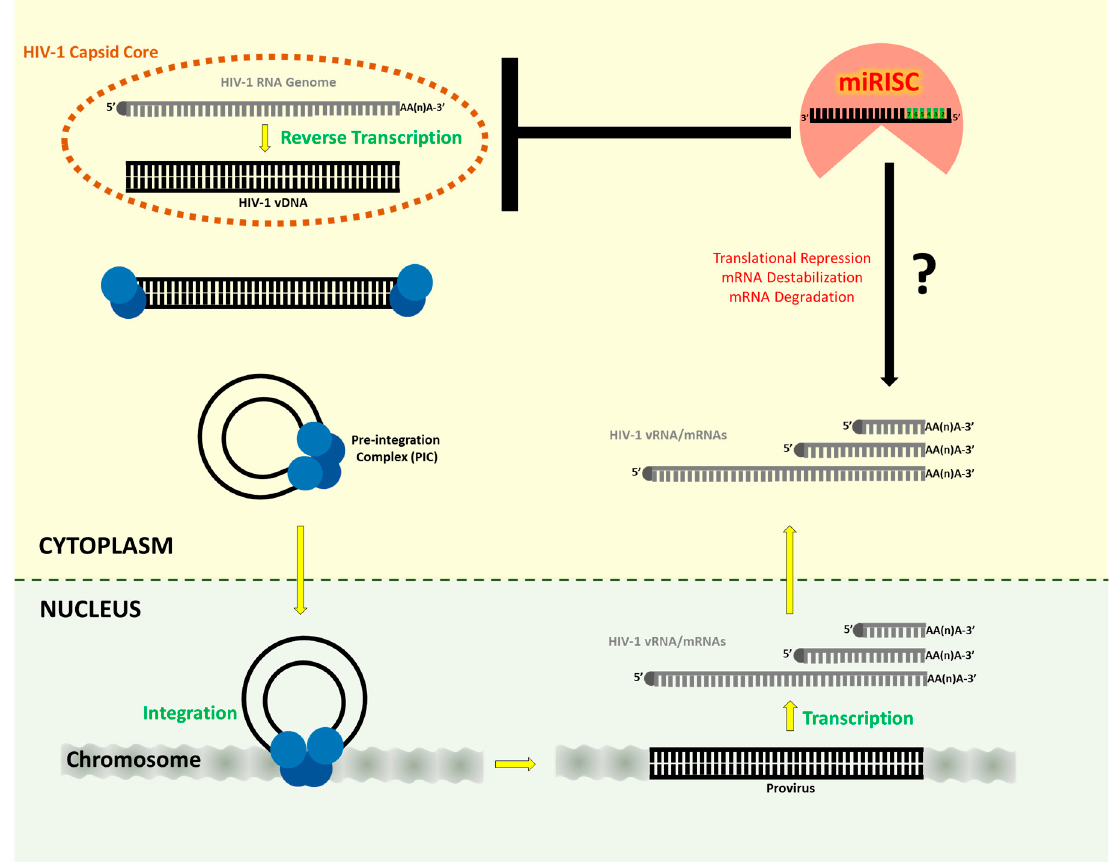
Figure 3. Schematic showing different stages of HIV-1 replication in a target cell and the potential site(s) of miRISC action. While the incoming HIV-1 RNA genome is protected by the viral capsid shell, thus precluding any access to the miRISC, the viral transcripts exported from the nucleus into the cytoplasm are potentially accessible and hence are viable targets of miRISC. However, it remains unclear whether the endogenous levels of cellular miRNAs are sufficient to effectively counter the high number of viral transcripts typically produced during HIV-1 infection. Yellow arrow = Indicates/depicts progression of the different stages of HIV-1 replication. Black arrow = Indicates/depicts the potential interaction of miRNAs with the HIV-1 RNAs. Black T bar = Indicates/depicts the protection provided by the viral capsid shell to the viral RNA genome against the cellular miRNAs.